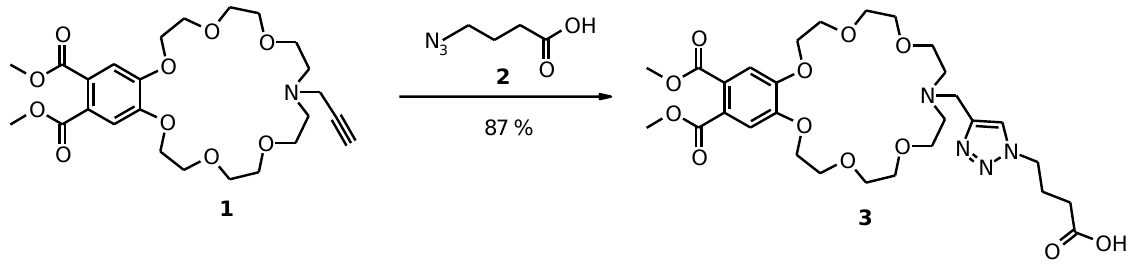
Scheme 1. Synthesis of the new lariat ether 3 by copper(I) mediated dipolar